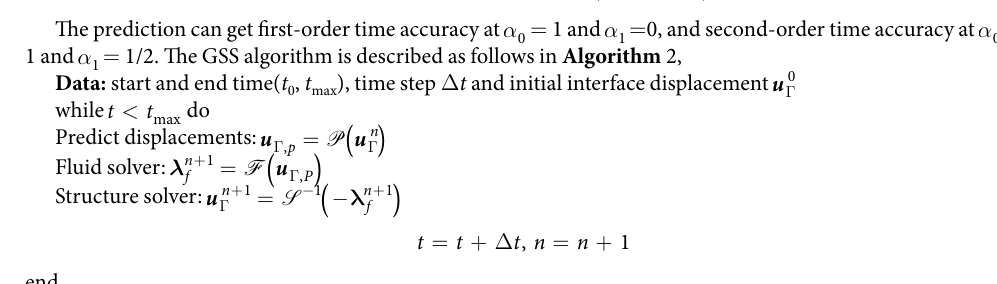
end Algorithm 2: Generalized Serial Staggered